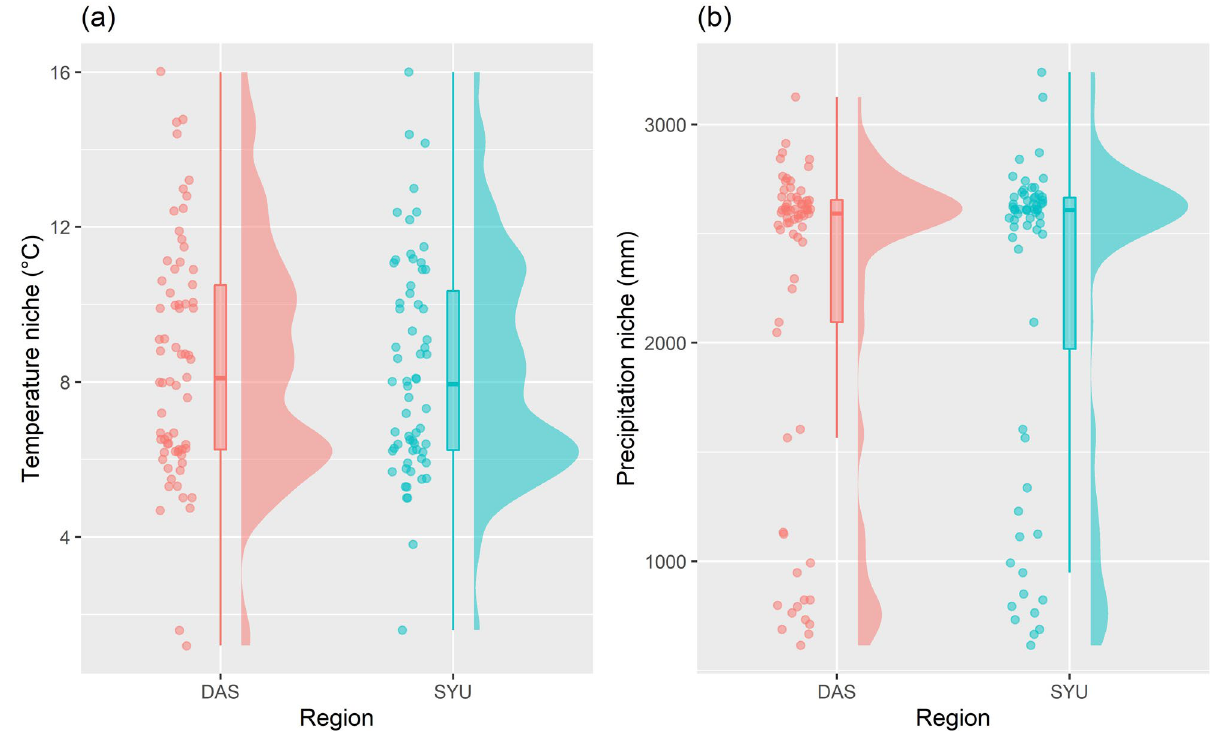
Figure 3. The species climate niche distribution of the Dashueiku Mountain (DAS) and the Syue Mountain (SYU) region, ( a ) temperature niche and ( b ) precipitation